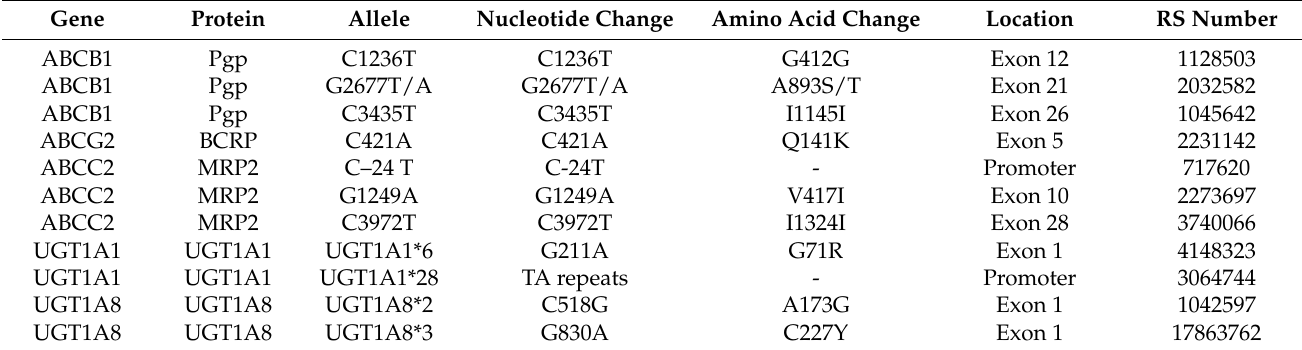
Table 1. Major transporters and metabolic enzymes single nucleotide polymorphisms